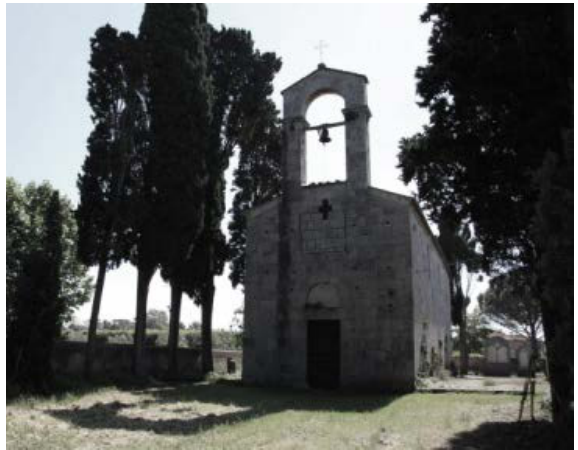
Figure 2. San Miniato church, the main façade